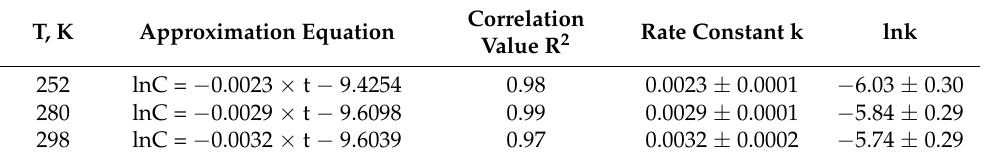
Figure 4. Linear forms of H 2 S sorption kinetic dependencies on ferromanganese ore.